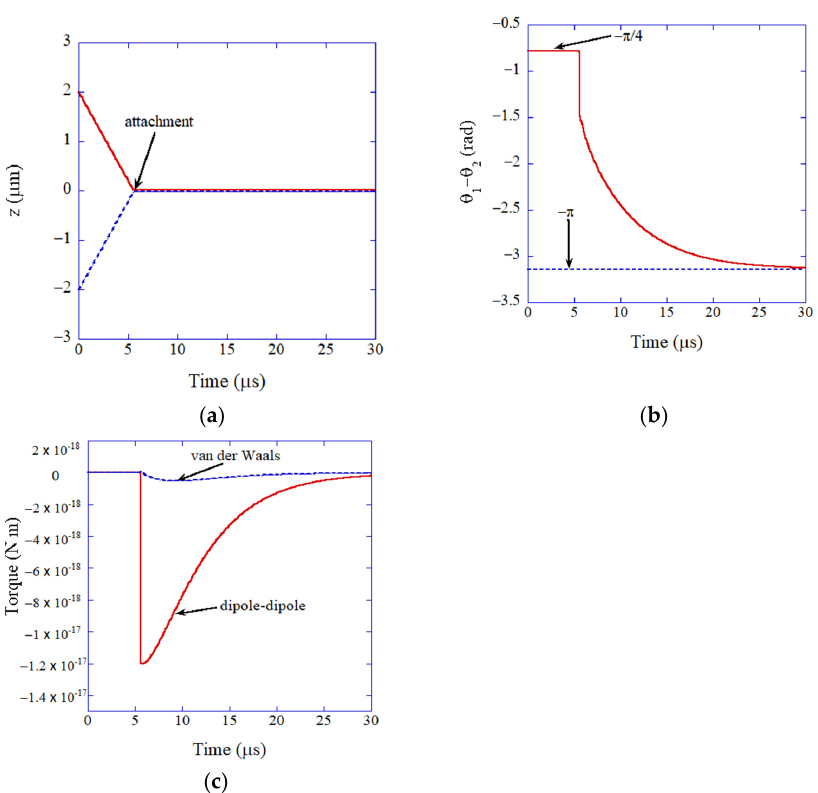
Figure 6. The results of numerical simulation of the ODE model for oriented attachment of BaTiO 3 nanocrystals (20 nm) in organic solvent (mesitylene) as a function of time ( a ) The position of nano- crystals. ( b ) The relative angle of the electric dipoles. ( c ) The torque. Reprinted with permission from Ref. [85]. Copyright 2015, the American Chemical Society.